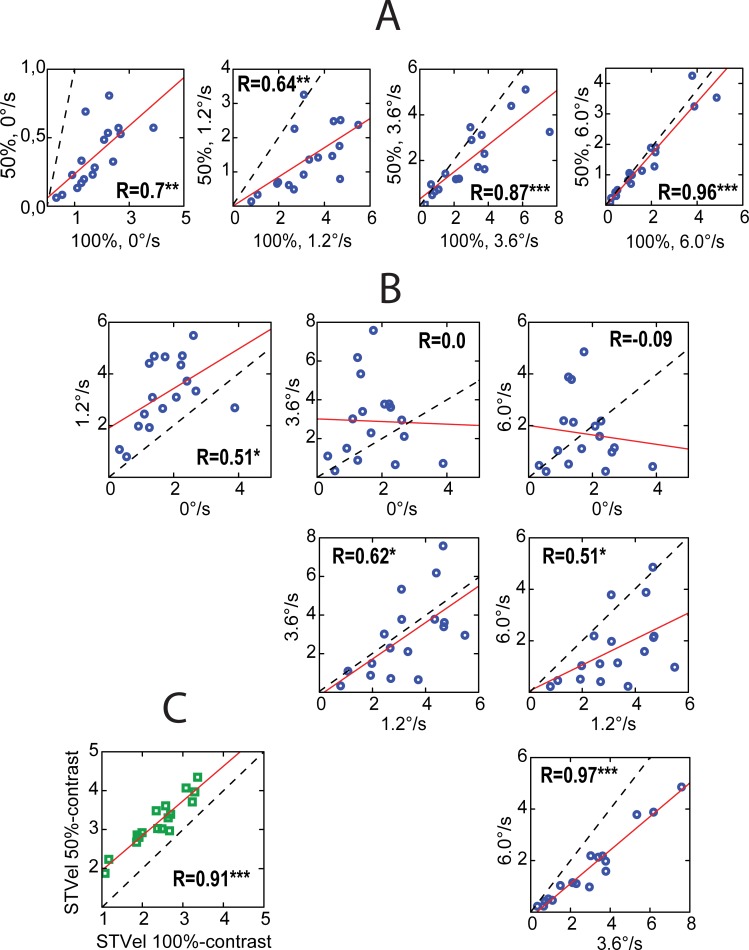
Rank-order consistency of the GR power across conditions.A. Correlations between GR power measured at 50% and 100% contrasts. B. Correlations between GR power values measured in different velocity conditions at 100% contrast (see S1 Fig in Supporting Information for a similar figure for the 50% contrast stimuli). Blue dots in A and B denote individual GR power values. C. Correlations between STVel values at the two contrasts. Green squares denote individual STVel values. The linear regression is shown in red. Dashed lines in all plots correspond to the axis of symmetry.